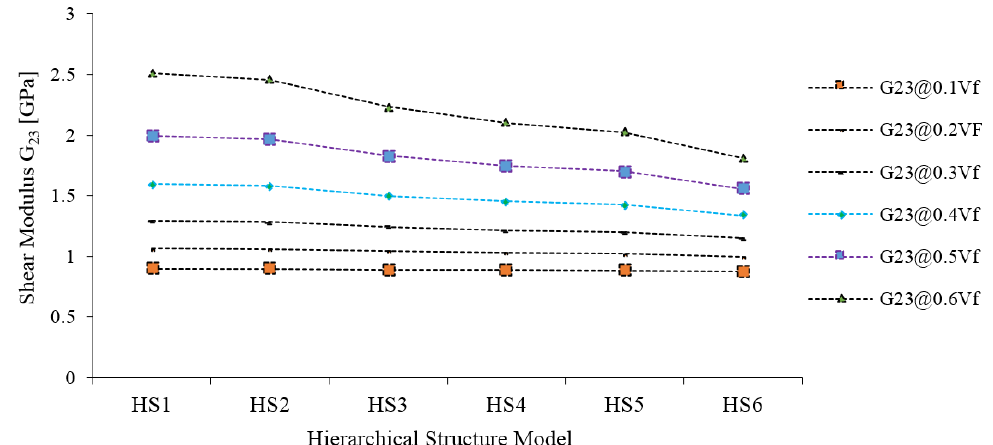
Figure 13. Out-of-plane shear modulus (G 23 ) of Jute fiber composites.